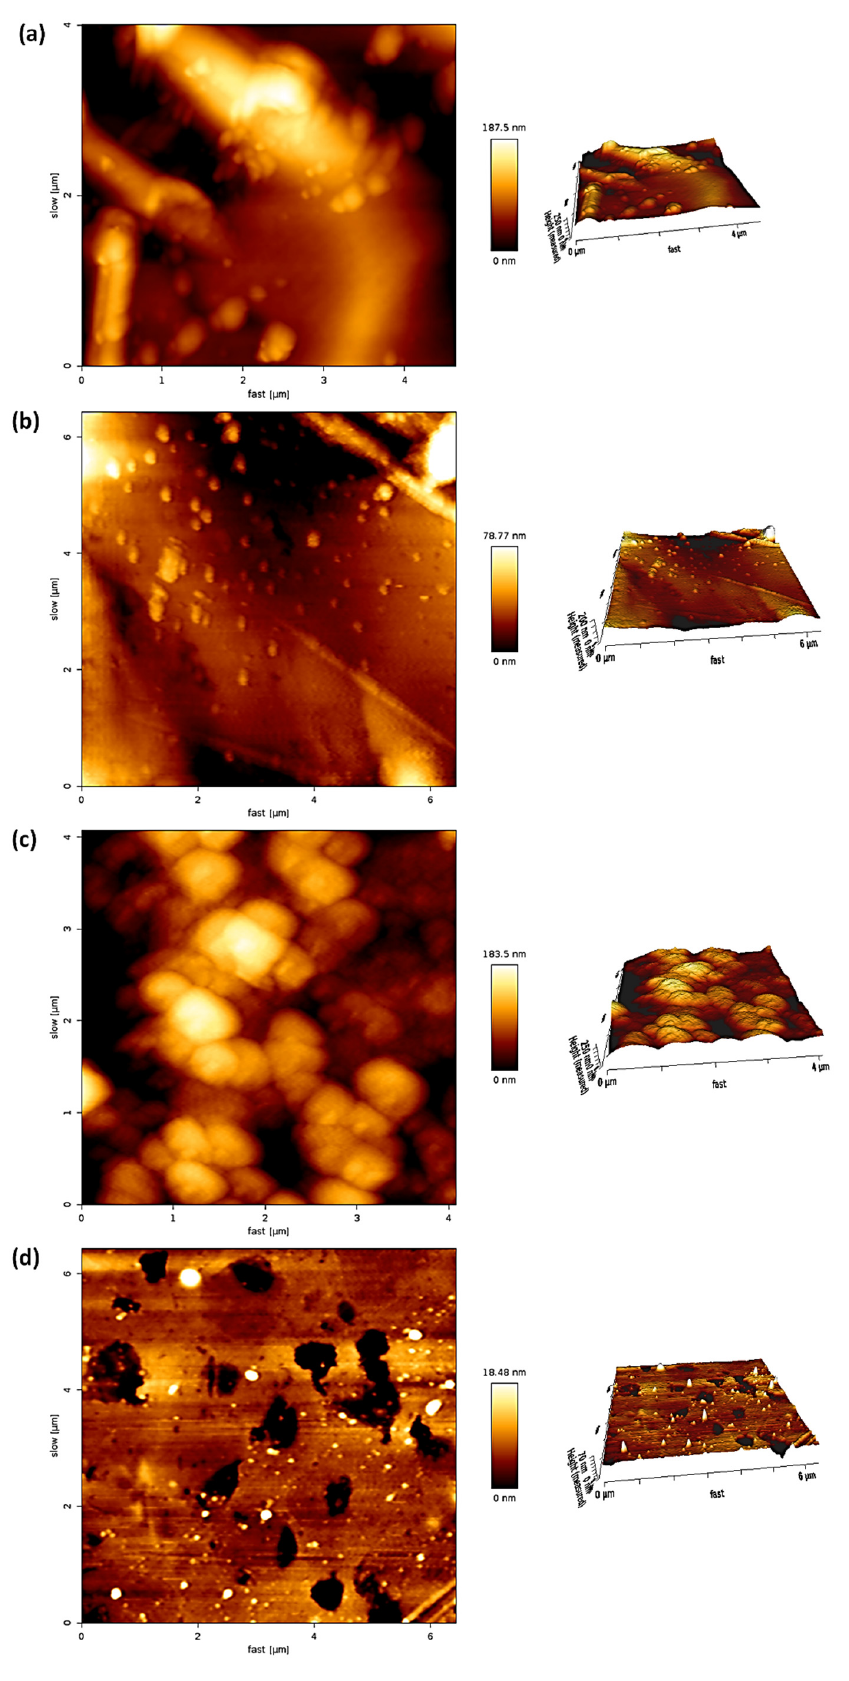
Figure 8. AFM images of ( a ) PVC, ( b ) PVC + 1 , ( c ) PVC + 2 and ( d ) PVC + 3 films.